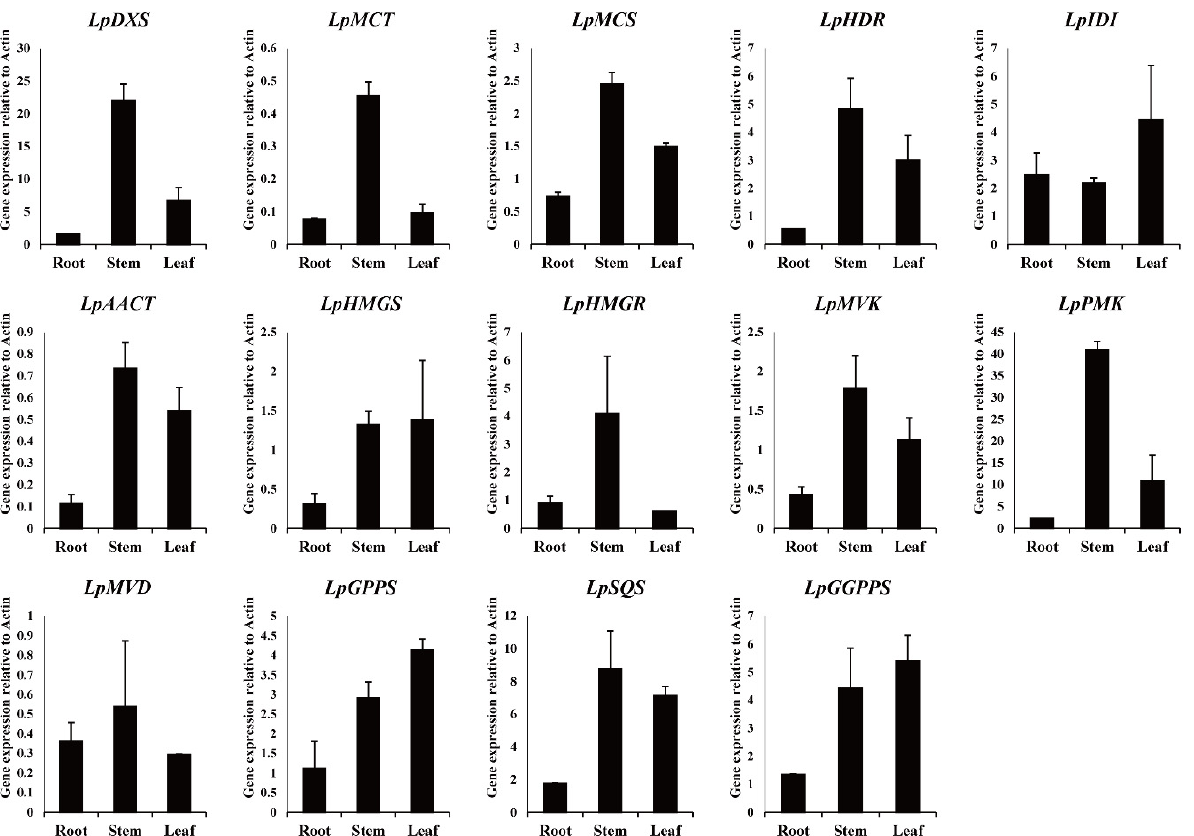
Figure 4. Expression of terpene biosynthetic genes in different organs of Lavandula pubescens .